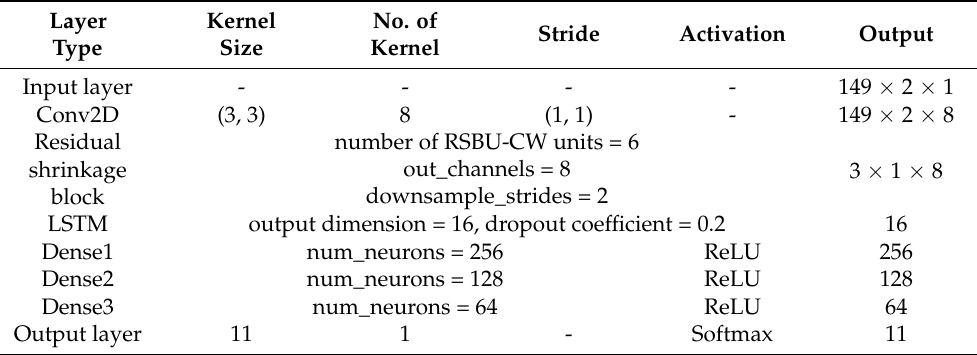
Table 3. Parameters used in experimental